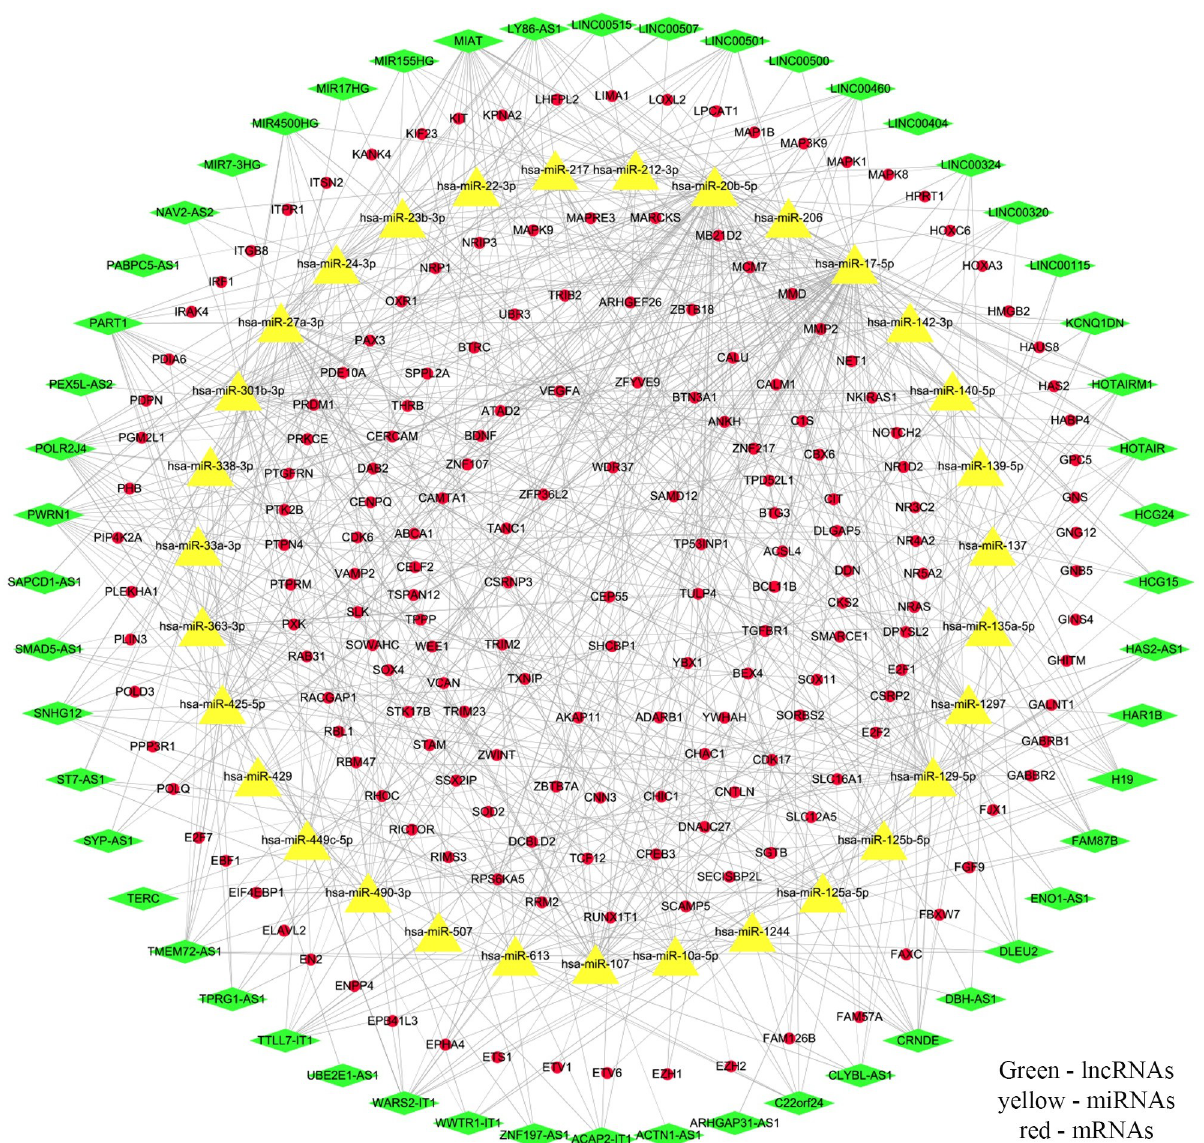
Fig 2. Constructing the ceRNA network from lncRNA and miRNA data. The interaction relationships between lncRNAs, miRNAs, and mRNAs were used to construct the ceRNA network. Green represents the 52 lncRNAs, yellow represents the 31 miRNAs, and red represents the 186 mRNAs.